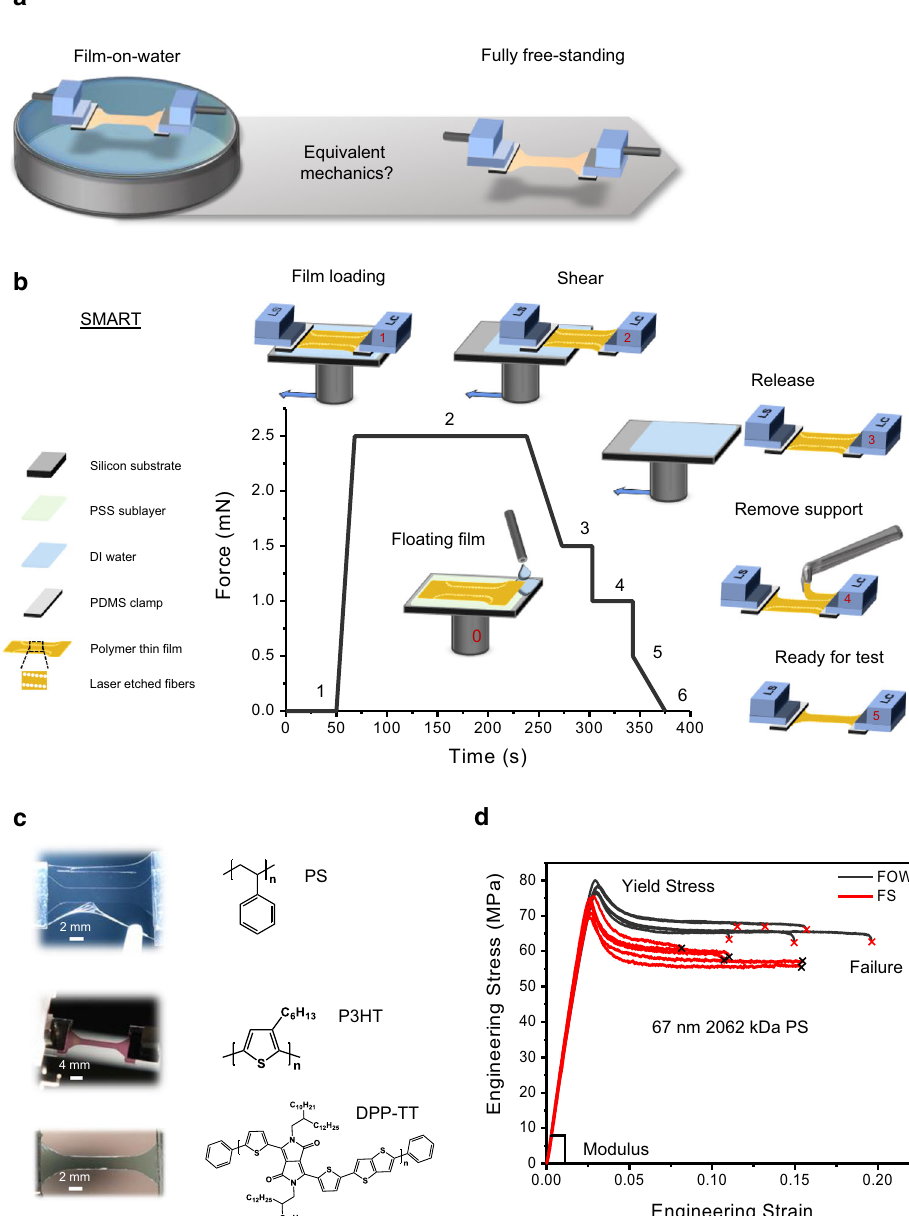
Fig. 1 Use of shear motion-assisted robust transfer (SMART) method to obtain ultrathin fi lms. a Illustration of the FOW and FS tensile tests. b SMART process and representative force applied to the fi lm for obtaining a free-standing dog bone for tensile analysis. c The three polymers investigated within this study and representative free-standing fi lms with a dog-bone gauge of 8 × 2 mm. From top – down: support removal from 19 nm high-molecular-weight PS, 80 nm P3HT prior to strain, DPP-TT prior to strain. d Representative stress – strain pro fi les for a 67 nm 2062 kDa PS fi lm from both FS and FOW